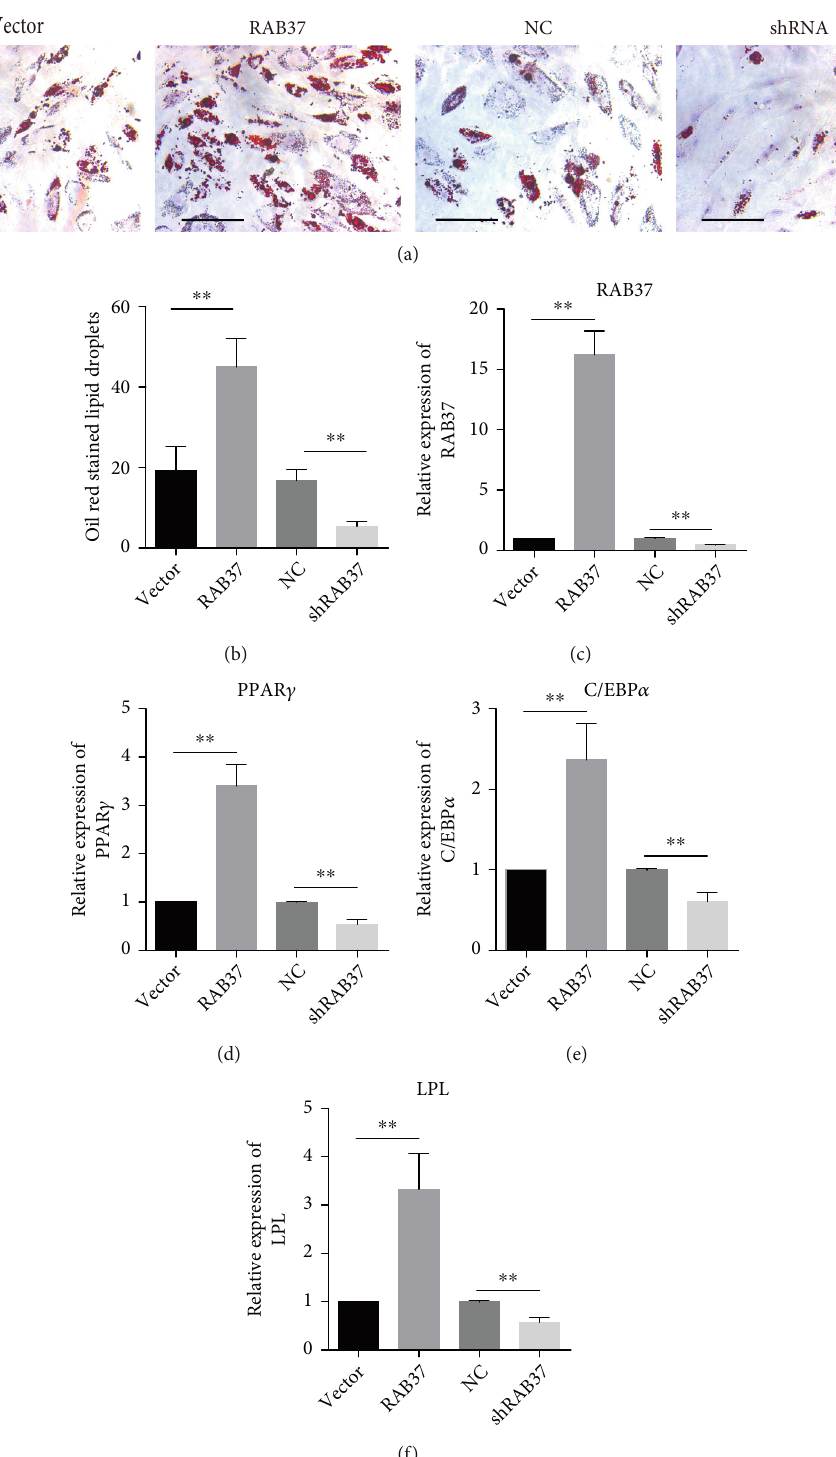
Figure 2: RAB37 promotes adipogenic di ff erentiation of ADSCs. hADSCs were infected with lentivirus expressing RAB37 or shRNA targeting RAB37 (shRAB37). Empty vector lentivirus (vector) or lentivirus containing scramble RNA (NC) served as control, respectively. Oil Red O staining was used to evaluate adipogenesis of hADSCs (a) ( scale bar = 300 μ m ). Oil Red O-stained hADSCs in six random views were counted (b), n = 6 . The expression of RAB37 (c), PPAR γ (d), C/EBP α (e), and LPL (f) were examined by qRT-PCR, n = 3 . Data are presented as means ± SD . ∗∗ p < 0 : 01 ; vector vs. RAB37, and NC vs.